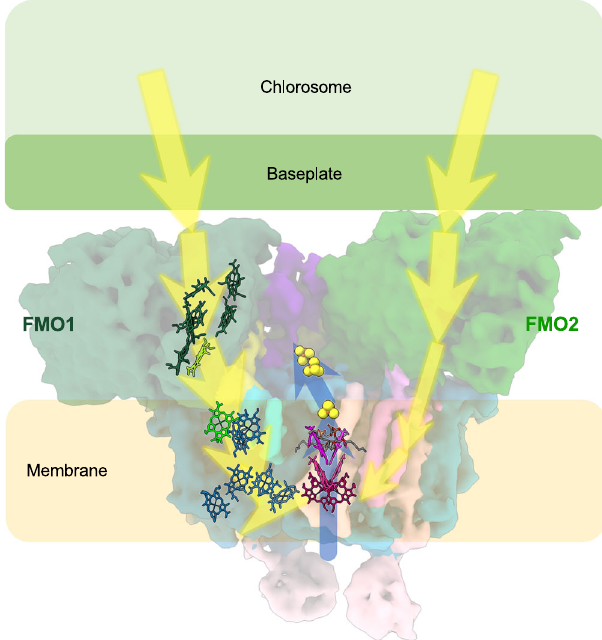
Fig. 5 | Proposed energy transfer and ETC pathways in the GsbRC-FMO 2 pho- tosynthetic supercomplex. Model for the energy transfer in the GsbRC-FMO 2 supercomplex. Yellow arrows are possible light excitation energy transfer path- ways. Blue arrows indicate the direction of the electron transport along the chlorophylls and iron-sulfur